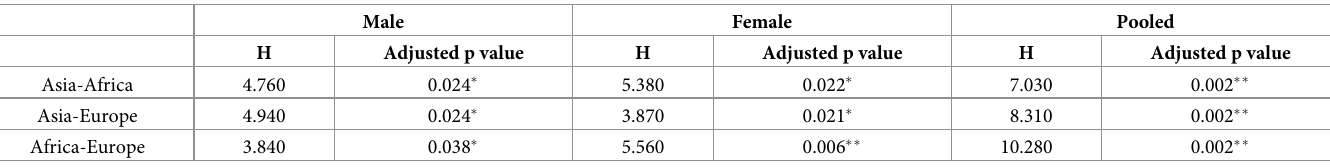
Table 3. Pairwise population comparisons within sexes.